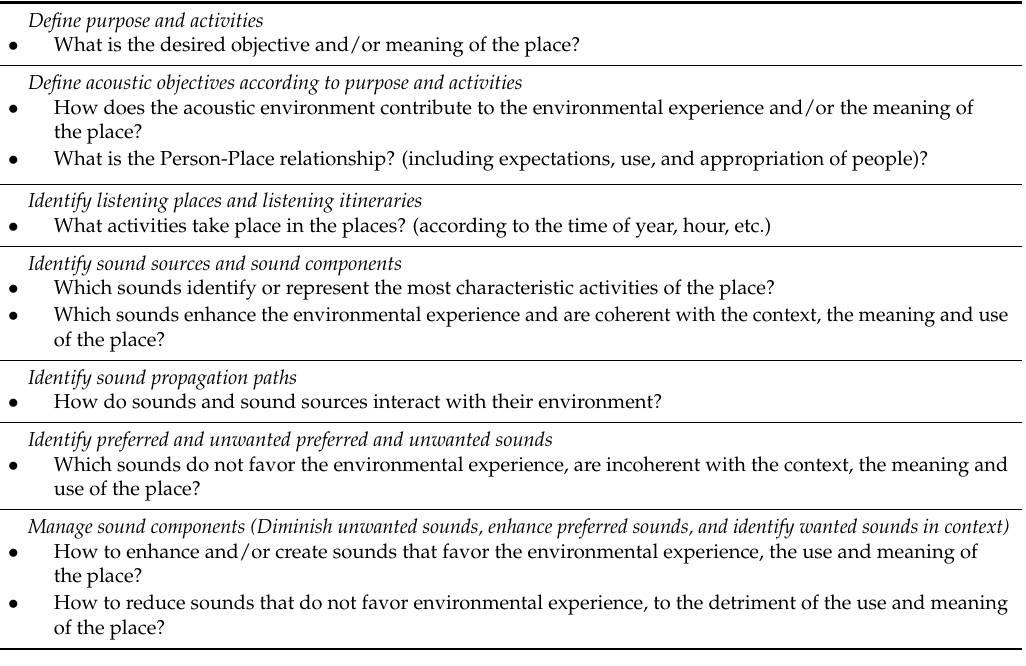
Table 4. Contextual and semiotic aspects in the Bento Coelho’s soundscape design